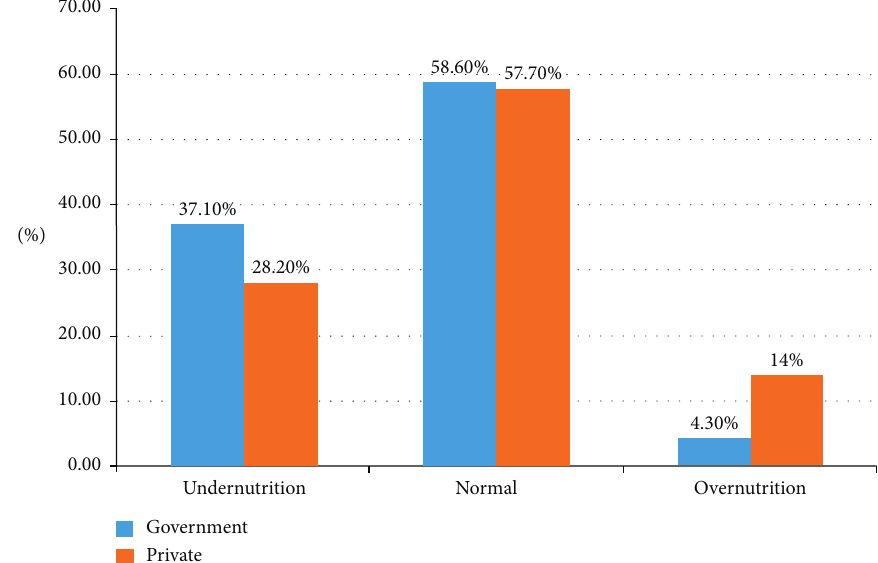
Figure 2: The comparison of nutritional status of primary school students in Gondar town,